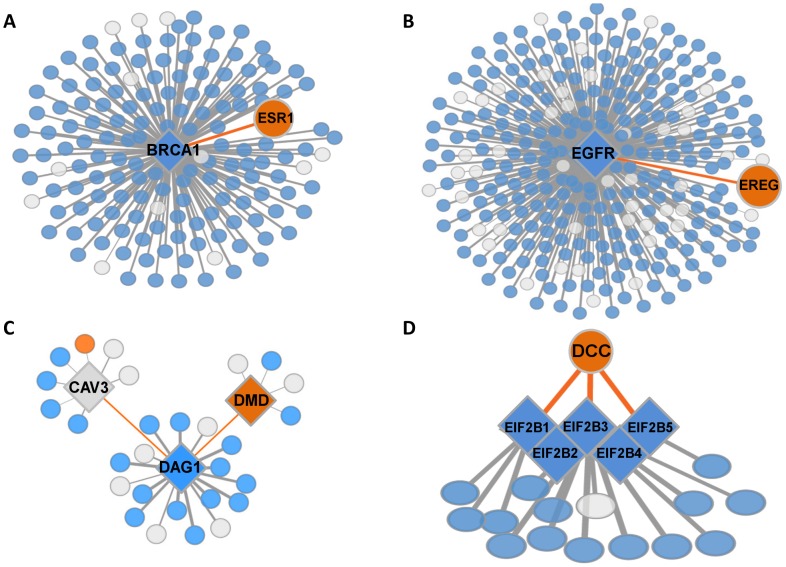
TS-PPIs illuminate disease-related tissue-specific effects of causal genes.Orange, blue and grey nodes denote tissue-specific, globally-expressed, and other proteins, respectively; diamond nodes mark hereditary disease genes; edges denote PPIs. A. BRCA1 is a globally-expressed tumor-suppressor hub, and ESR1 is an estrogen receptor protein that activates cellular proliferation. The breast-specific PPI linking BRCA1 and ESR1 provides a potential basis for the breast-specific effects of BRCA1 germline mutations [44]. B. A lung-specific PPI connects the widely-expressed epidermal growth factor receptor EGFR and its ligand protein epiregulin (EREG). Germline mutations in EGFR lead to lung cancer [30], and EREG was shown to confer invasive properties in an EGFR-dependent manner [31]. C. Muscle-specific PPIs connect the widely expressed trans-membrane cell adhesion receptor dystroglycan 1 (DAG1) to its muscle-specific ligand dystrophin (DMD), and to caveolin 3 (CAV3) which regulates DMD by preventing the DAG1-DMD PPI. Mutations in all three genes give rise to various forms of muscular dystrophies. D. The brain-specific PPIs that link members of the globally-expressed protein complex EIF2B to the netrin-1-receptor DCC may underlie the brain-specific effects of germline mutations in EIF2B complex members [35].